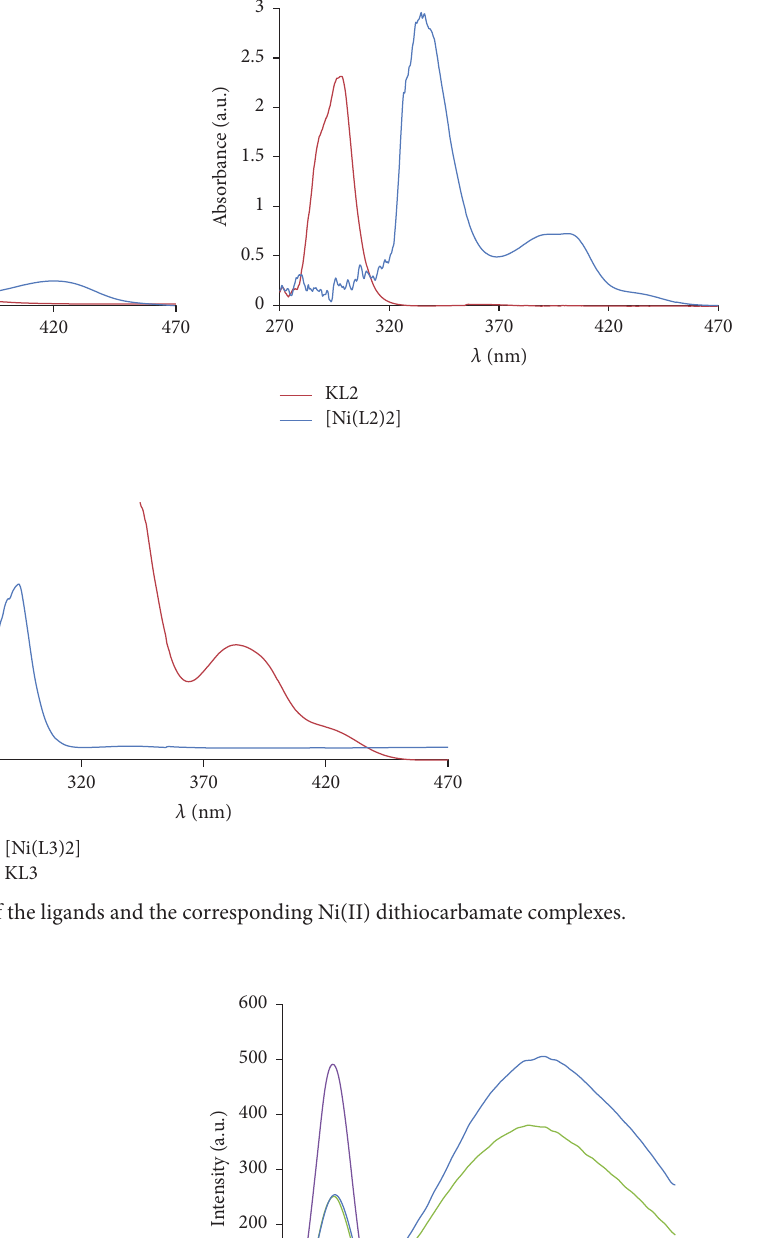
The emission maxima were found to be red-shifted in com- parison to the optical absorption band edges. The broadening